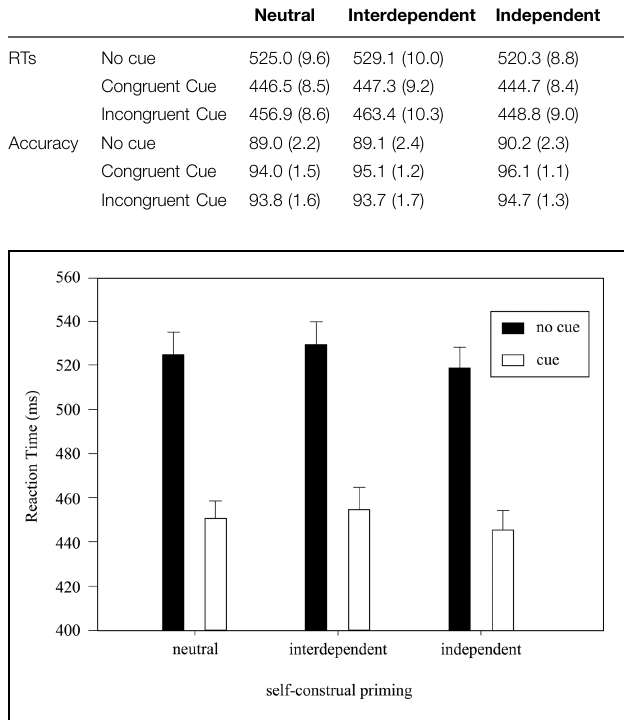
FIGURE 2 | The mean reaction times (RTs) by Cue Presence and Priming. Error bar indicates standard error of the mean